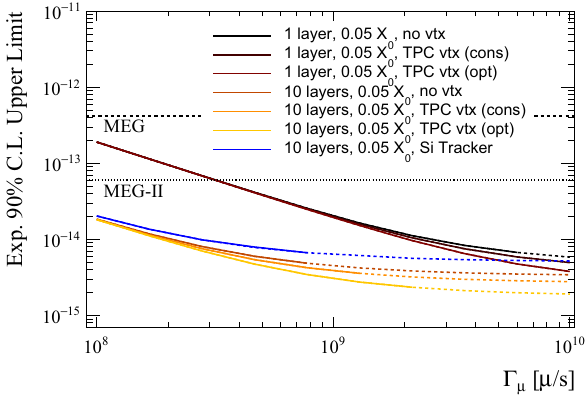
Fig. 7 Expected 90% C.L. upper limit on the Branching Ratio of μ + → e + γ in different scenarios for a 3-year run. A few different designsbasedonthephotonconversiontechniquearecompared,includ- ing the TPC vertex detector option in the conservative and optimistic hypotheses. The lines turn from continuous to dashed when the number of background events exceeds 10. The horizontal dashed and dotted lines show the current MEG limit and the expected MEG-II sensitivity,